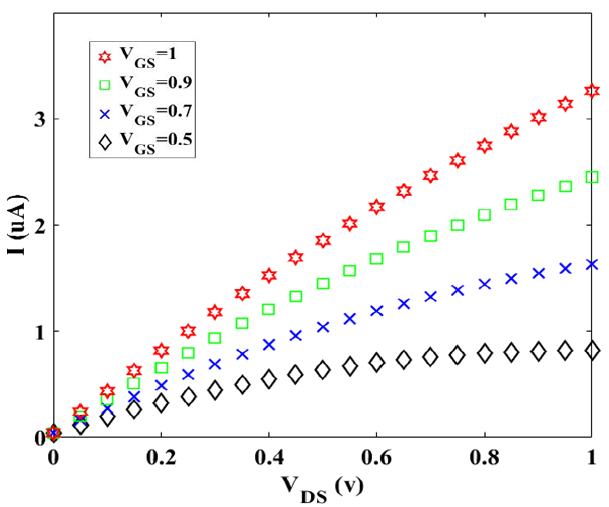
Figure 5. I-V characteristic for different values of VGS at room temperature.